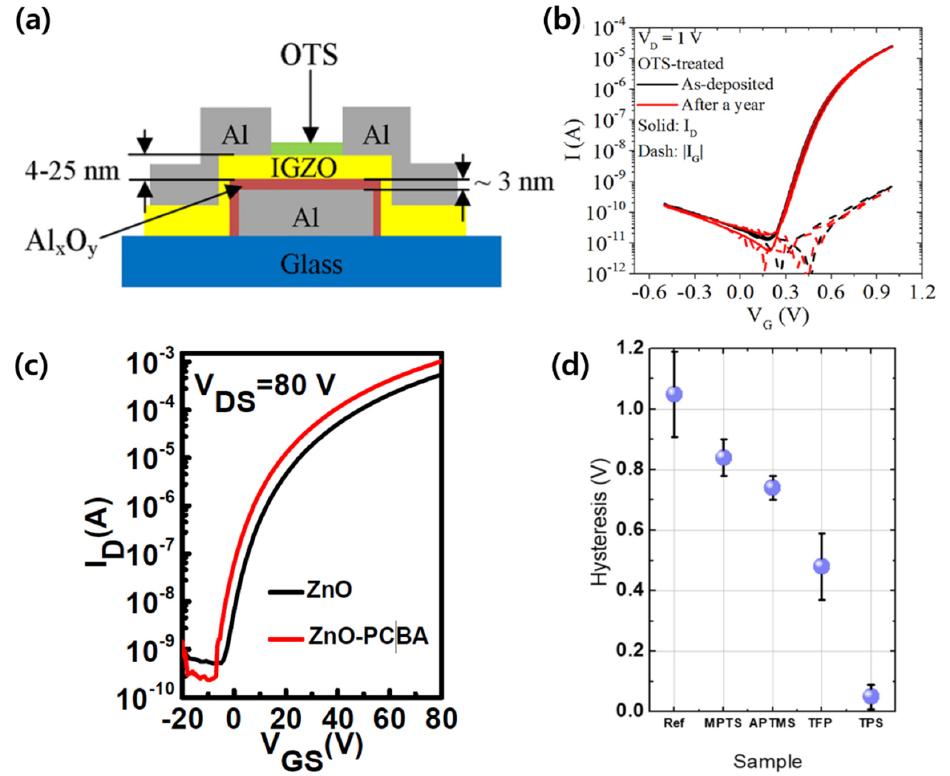
Figure 6. SAMs as dopants in oxide semiconductor-based transistors ( a ) Schematic of ODTS-treated IGZO TFT (adapted from [79] with permission from the American Chemical Society). ( b ) Transfer characteristics of IGZO TFT immediately after ODTS treatment and 1 year later (adapted from [79] with permission from the American Chemical Society). ( c ) Comparison of pristine ZnO TFT and PCBA-treated ZnO TFT transfer characteristics (adapted from [81] with permission from MDPI). ( d ) Hysteresis characteristics of IGZO TFT according to SAM (adapted from [78] with permission from the American Chemical Society).